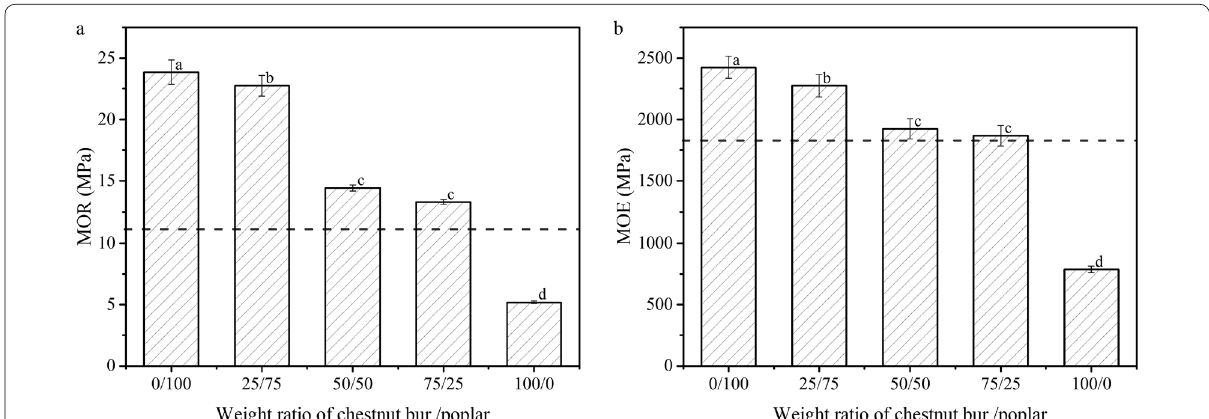
Fig. 5 Bending strength of composite particleboard. a The effect of the weight ratio of chestnut bur /poplar on the MOR of particleboard. b The effect of the weight ratio of chestnut bur/poplar on the MOE of particleboard. Error bars indicate standard deviations. Different letters in the figure indicate that means are significantly different ( p <